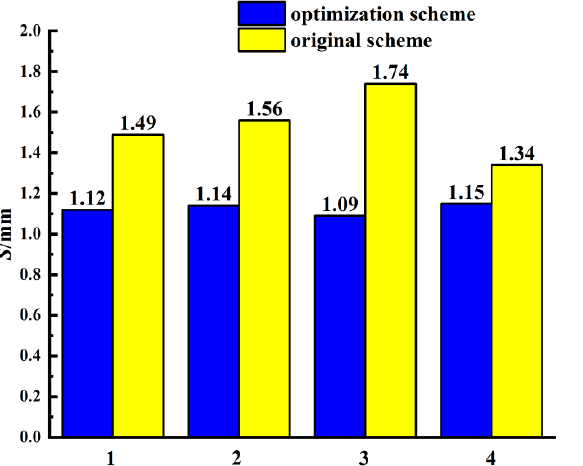
Figure 18. The monitoring point displacement of the tunnel portal with the optimization scheme and the original scheme.